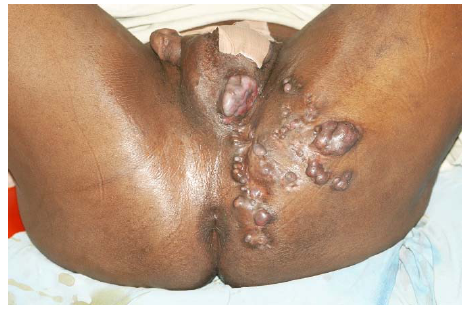
Figure 10. Massive gluteal, perineal and scrotal eumycetoma.